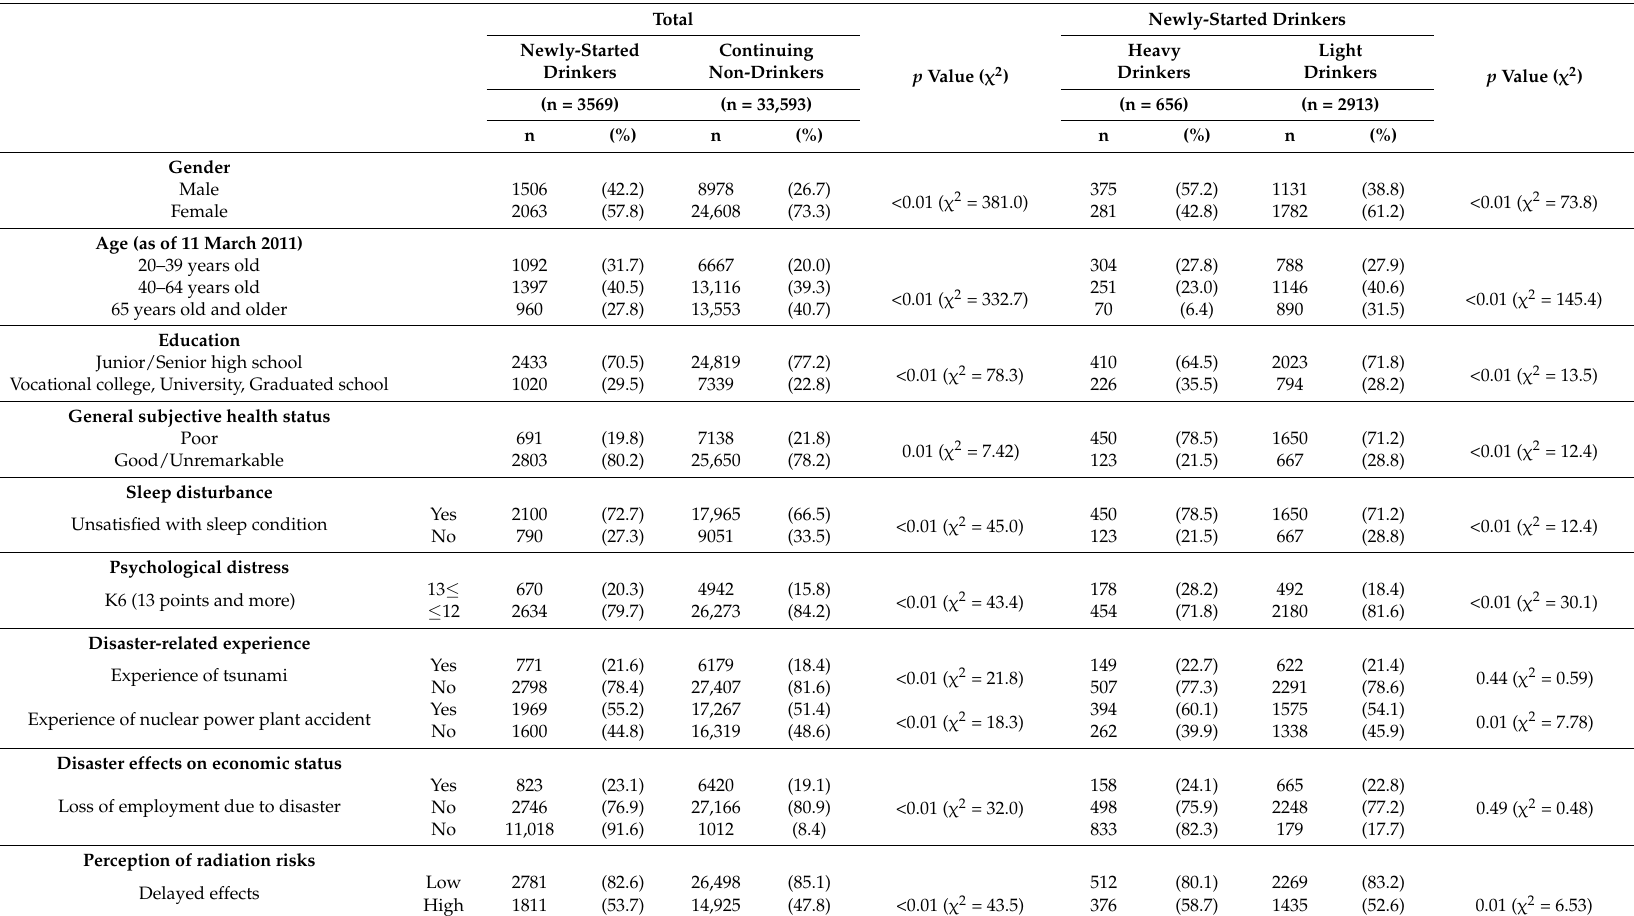
Table 2. Characteristics of newly-started drinkers and continuing non-drinkers in the 2012